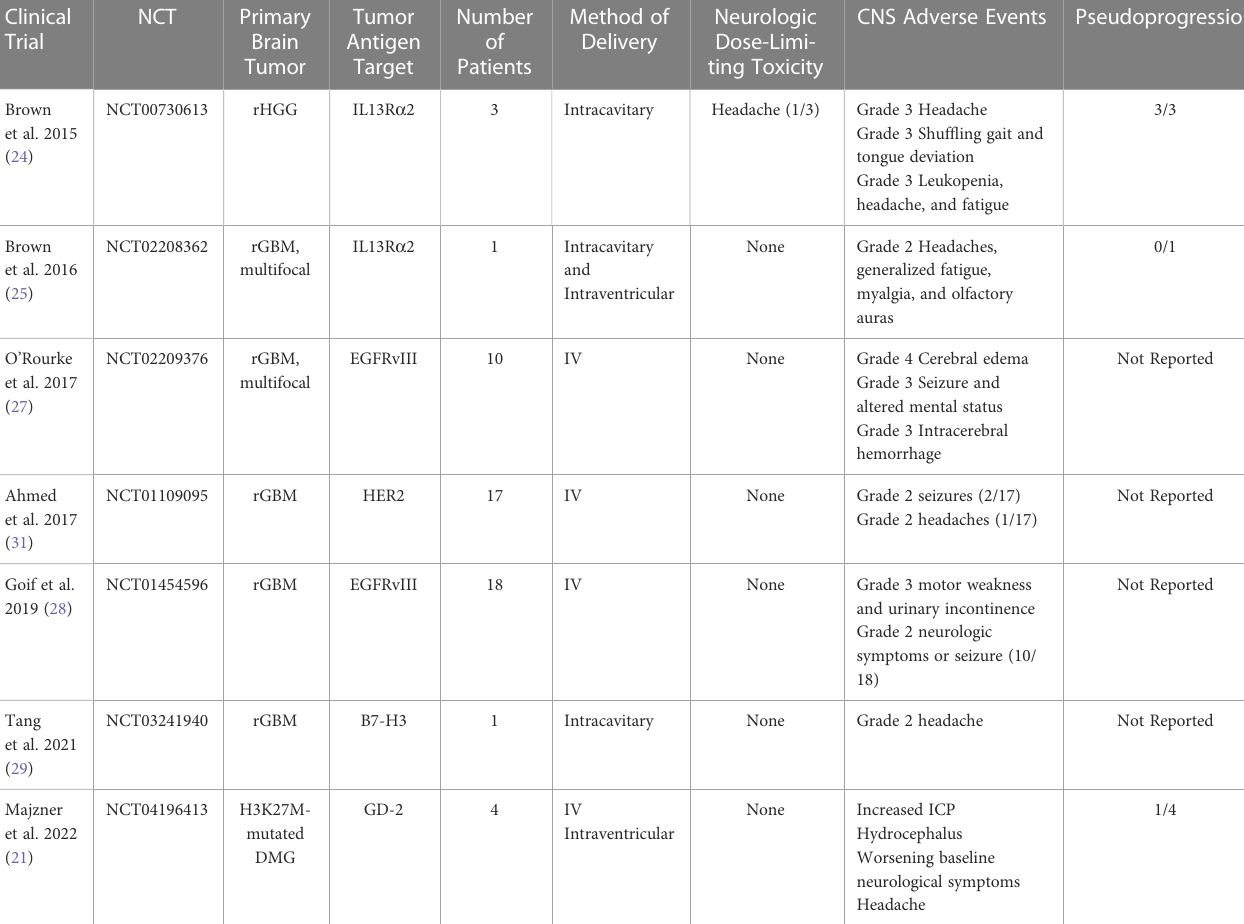
TABLE 1 CNS Toxicity of Primary Brain Tumor CAR-T Trials. Clinical